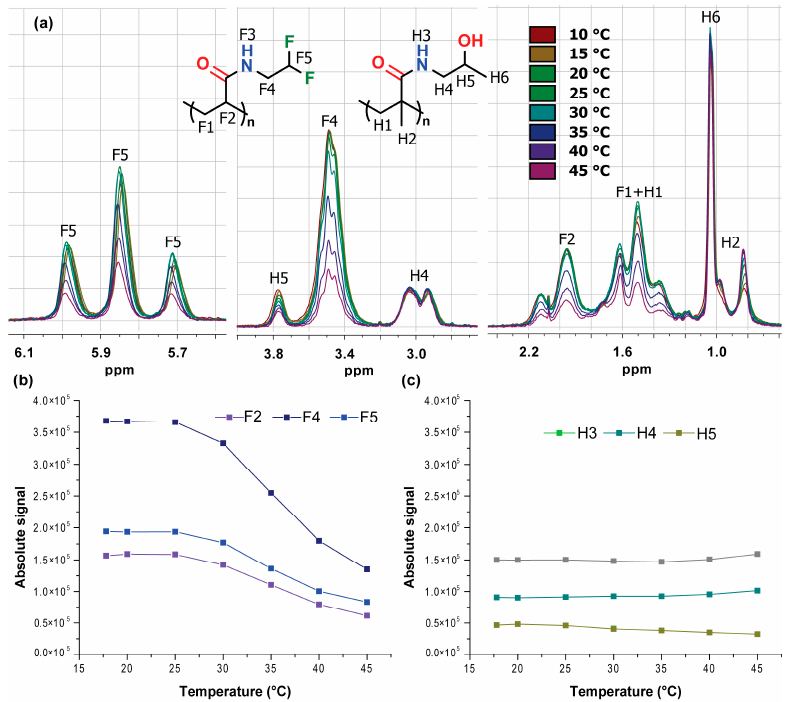
Figure 6. ( a ) Temperature dependence of 1 H NMR spectra from 10 °C to 45 °C. Regions with important peaks are magnified; ( b ) signal integrals from PDFEA and ( c ) PHPMA as a function of temperature.